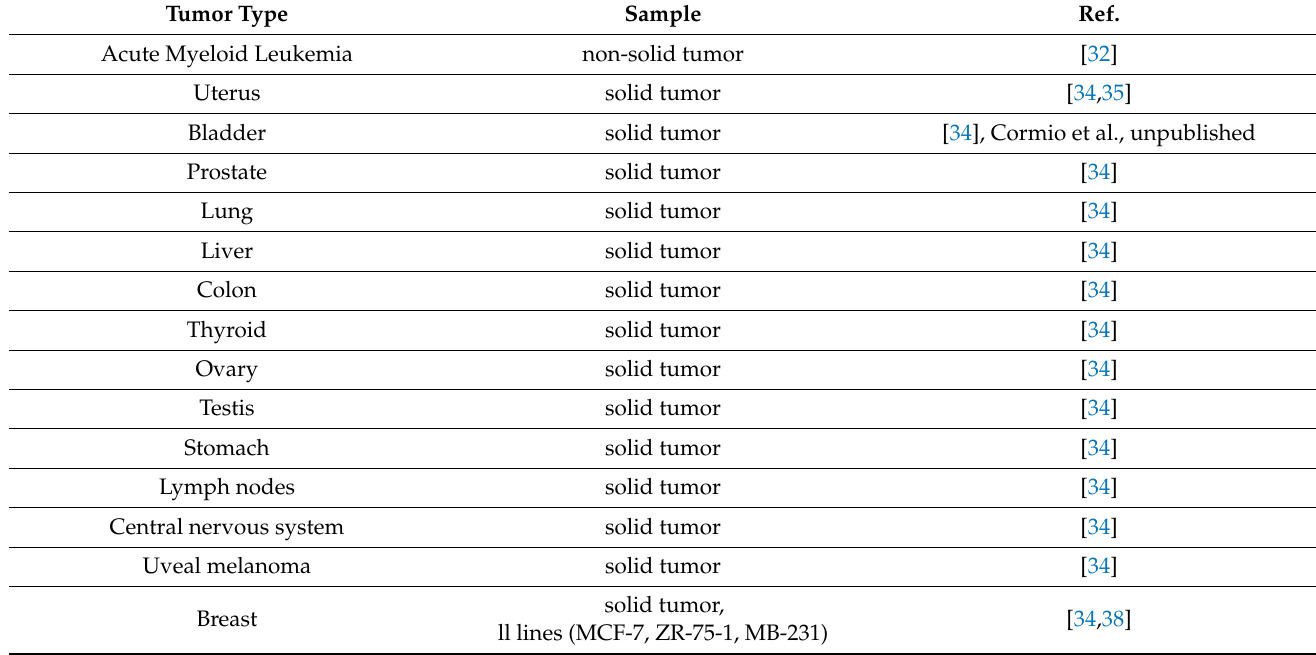
Table 1. Overexpression of ClpP in different